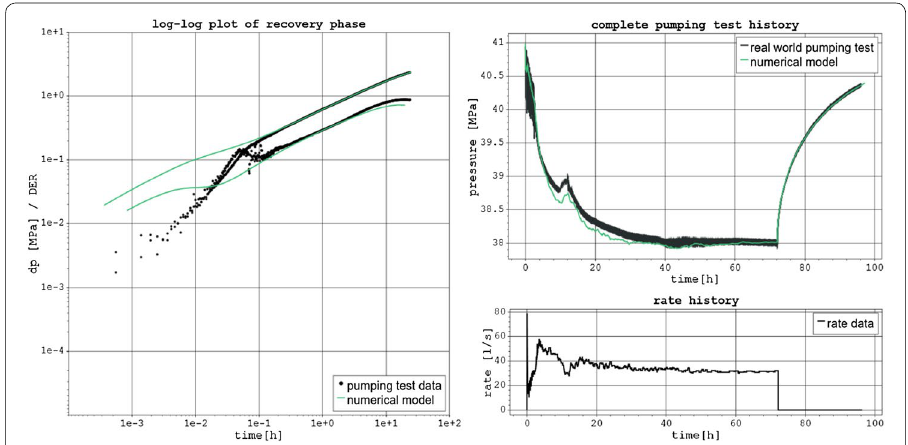
Fig. 8 Calibration results; left: log–log plot of recovery phase; right: pressure and rate history of complete pumping